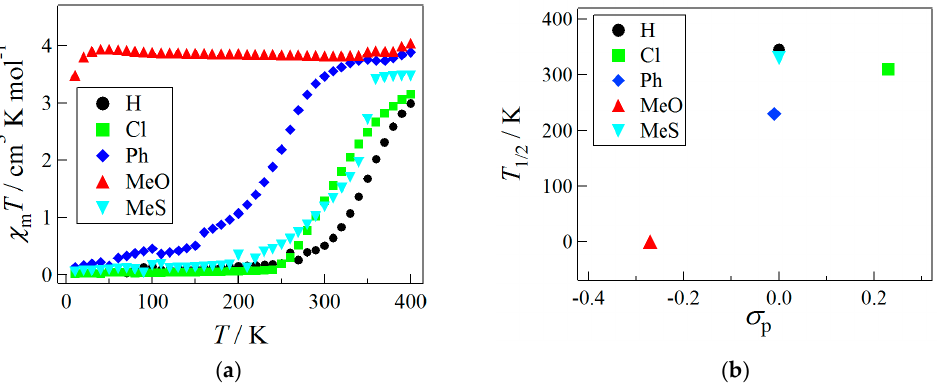
Figure 2. ( a ) Temperature dependence of χ m T for polycrystalline [Fe(X-pybox) 2 ](ClO 4 ) 2 measured at 5000 Oe; ( b ) The spin transition temperature T 1/2 as a function of the Hammett substituent constant σ p . The CH 3 O data point is tentatively placed at 0 K.